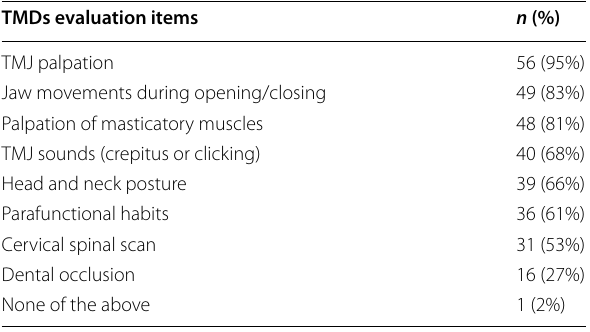
Table 2 Most common methods used for TMDs evaluation ( n 59)